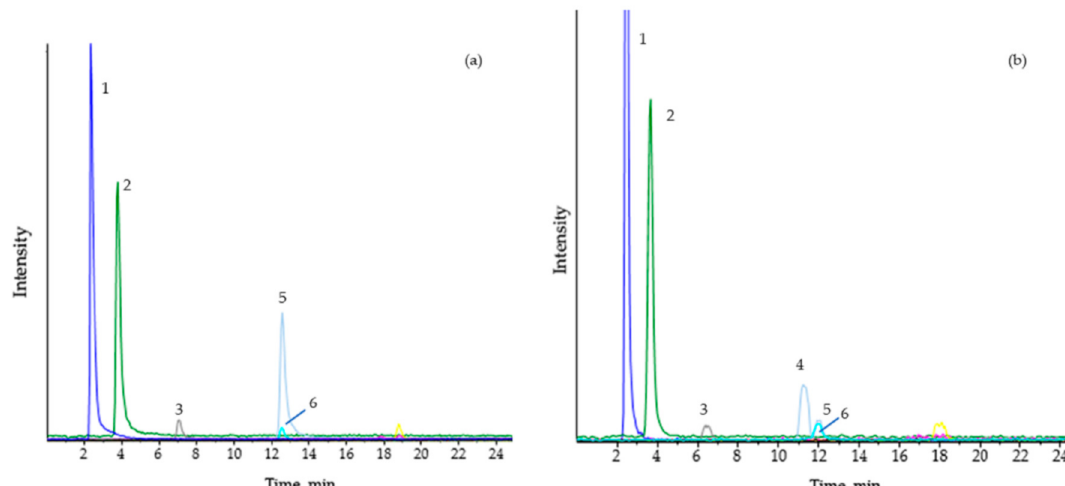
Figure 3. Analysis of short-chain acylcarnitines isomers in serum by HPLC/MS/MS as described by Ferrer et al. (2007) [59]. ( a ) Short-chain acyl-CoA dehydrogenase deficiency. ( b ) Isobutyryl-CoA dehydrogenase deficiency. (1) C0, free carni- tine; (2) C2, acetylcarnitine; (3) C3, propionylcarnitine; (4) C4, isobutyrylcarnitine; (5) C4, butyrylcarnitine; (6) d3-C4, d3-butyrylcarnitine (internal